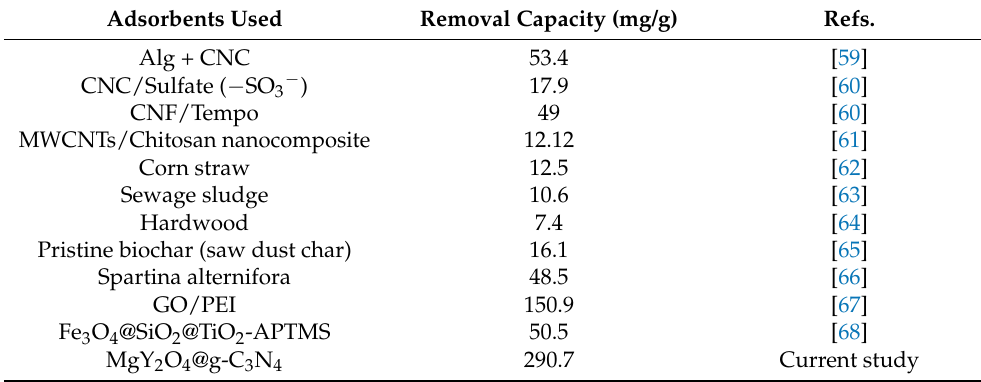
Table 3. Comparison of MgY 2 O 4 @g-C 3 N 4 adsorption parameters with various adsorbents.